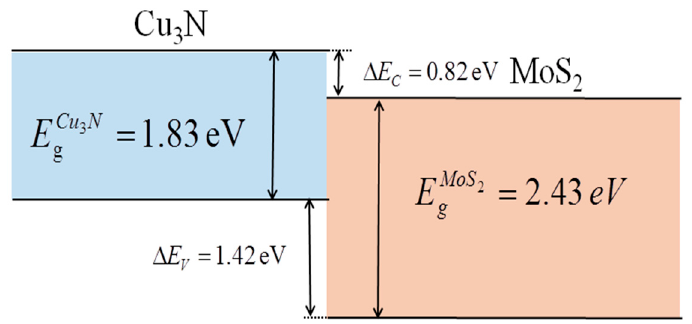
Figure 5. Band diagram of the Cu 3 N/MoS 2 interface.